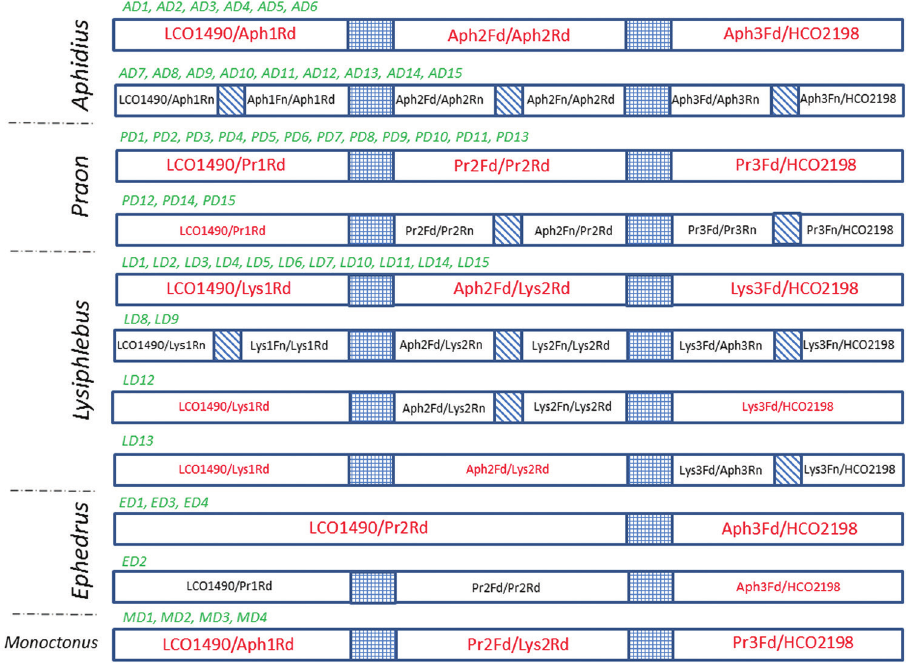
Figure 7. Scheme with overview of PCR attempts to recover the barcoding region of cytochrome c oxidase subunit I with novel primers from archival specimens from the genera Aphidius , Praon , Lysiphlebus , Ephedrus and Monoctonus . Primer pairs coloured red were used in direct PCR; black coloured primers were used in secondary nested reactions. Positions where short fragments within the subsequences overlap are marked with a